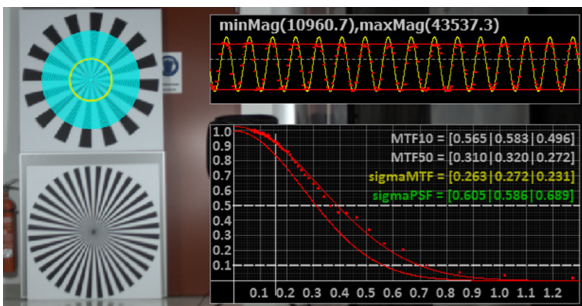
Figure 4. Designated test pattern Siemens-star (left), radial modulation analysis (top-right), resulting MTF and PSF